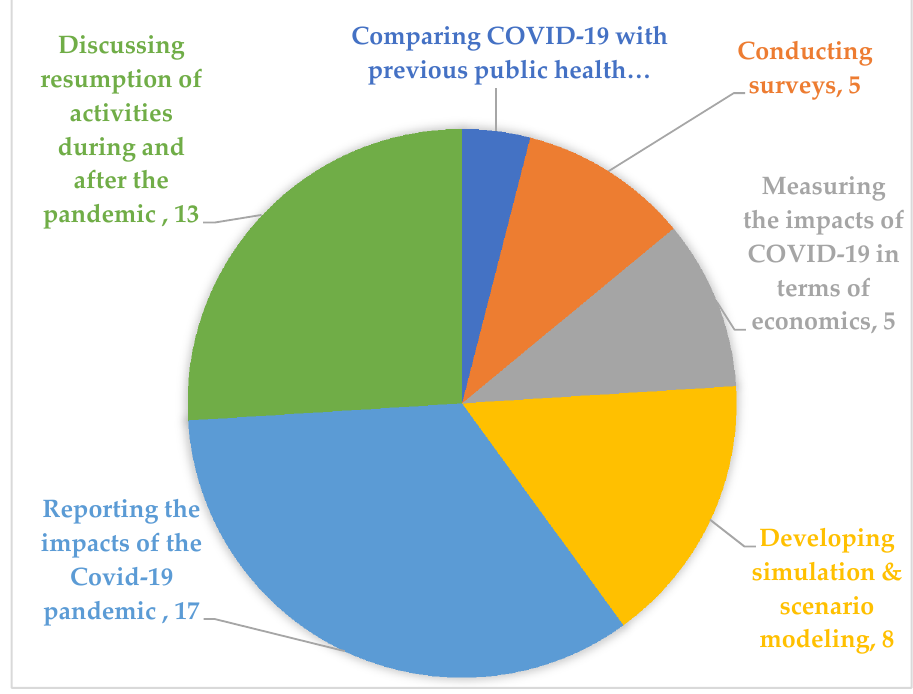
Figure 5. Research approach among included papers.